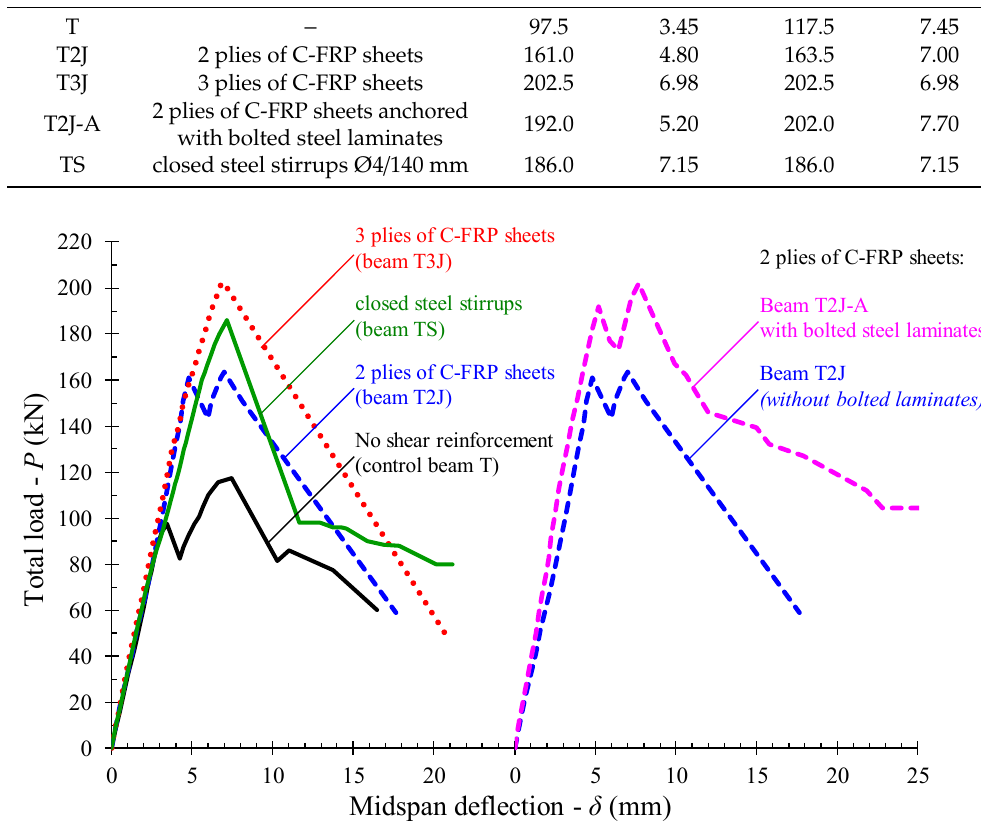
Figure 4. Total applied load versus midspan deflection experimental curves. Table 1. Test results.